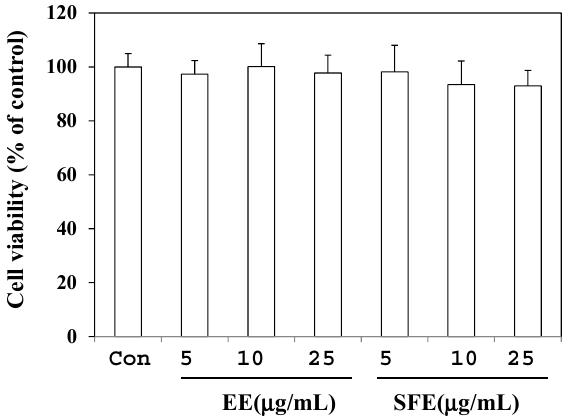
Figure 2. Effects of SFE (50 ◦ C, 400 bar, 3 h, and CO 2 flow rate of 60 mL/min) and EE (shaking incubation for 6 h at 60 ◦ C) on cell viability. Cell viability was determined using the EZ-Cytox cell viability assay kit. The cells were treated with various concentrations of SFE and EE for 24 h. After the incubation period, 10 µ L of the kit solution were added to each well and incubated for an additional 4 h. Data are presented as means ± SD ( n = 3). p < 0.05 vs. control.